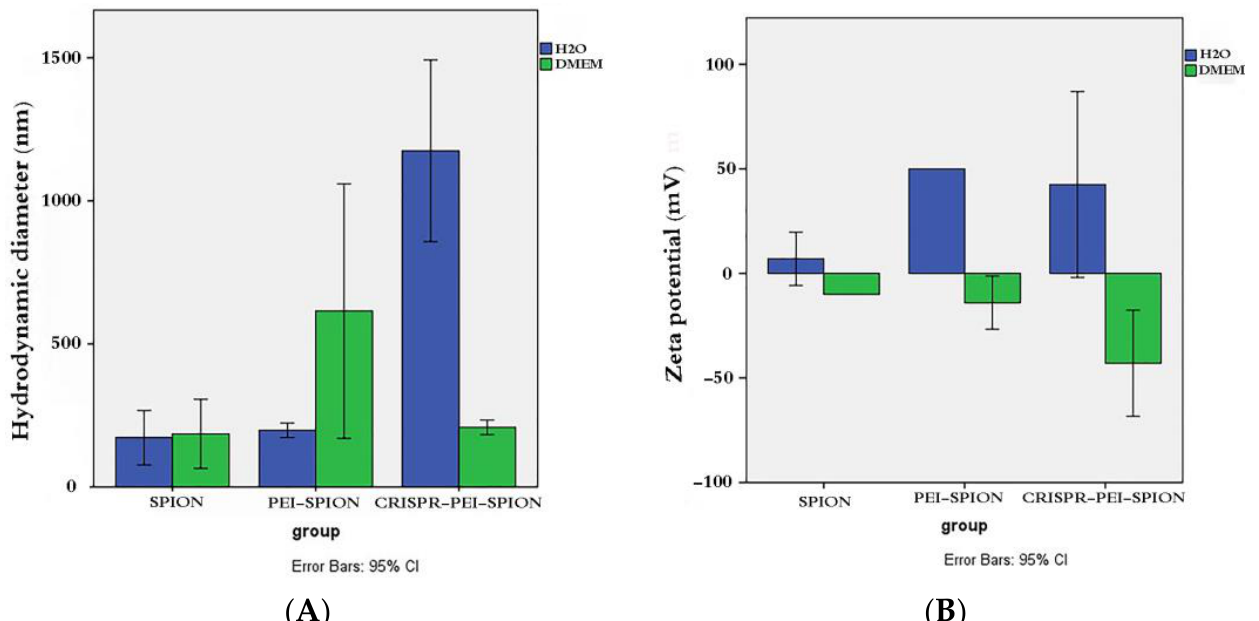
Figure 2. ( A ) Hydrodynamic diameter of magnetic nanoparticles (MNPs), PEI-MNPs, CRISPR/Cas9-PEI-MNPs in the presence of water and DMEM at pH 7.0 (mean ± S.D.; n = 3). ( B ) Zeta potential of magnetic nanoparticles (MNPs), PEI-MNPs, CRISPR/Cas9-PEI-MNPs in the presence of water and DMEM at pH 7.0 (mean ± S.D.; n = 3).